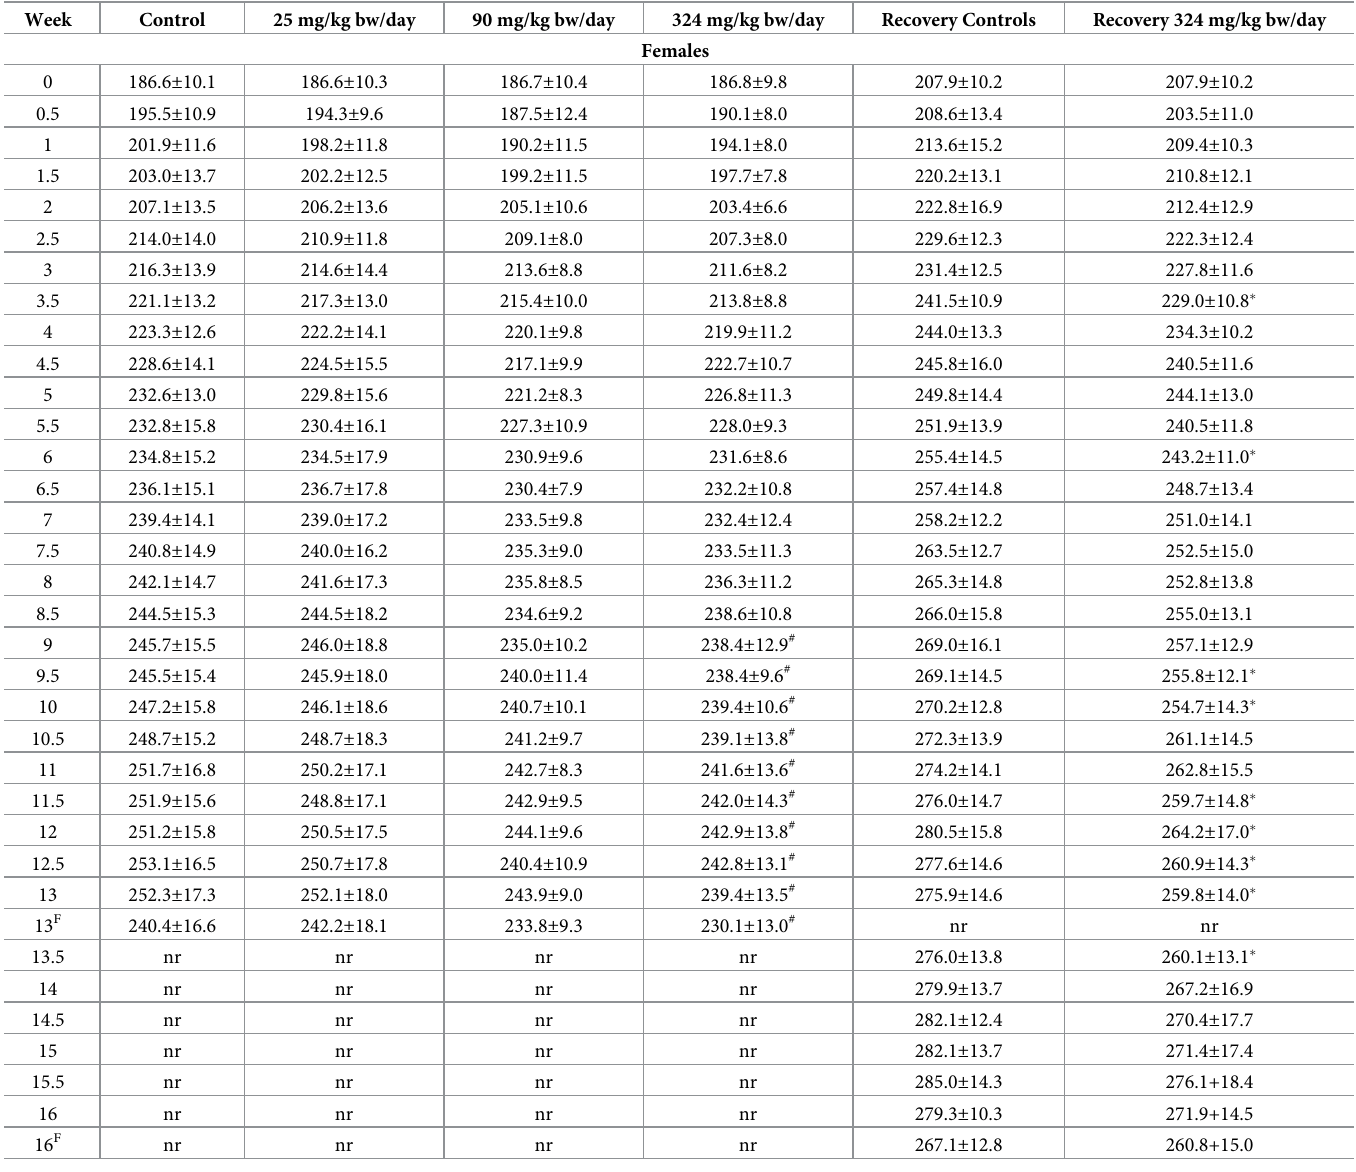
Table 2. Body weights for the 90-day study—Main and recovery